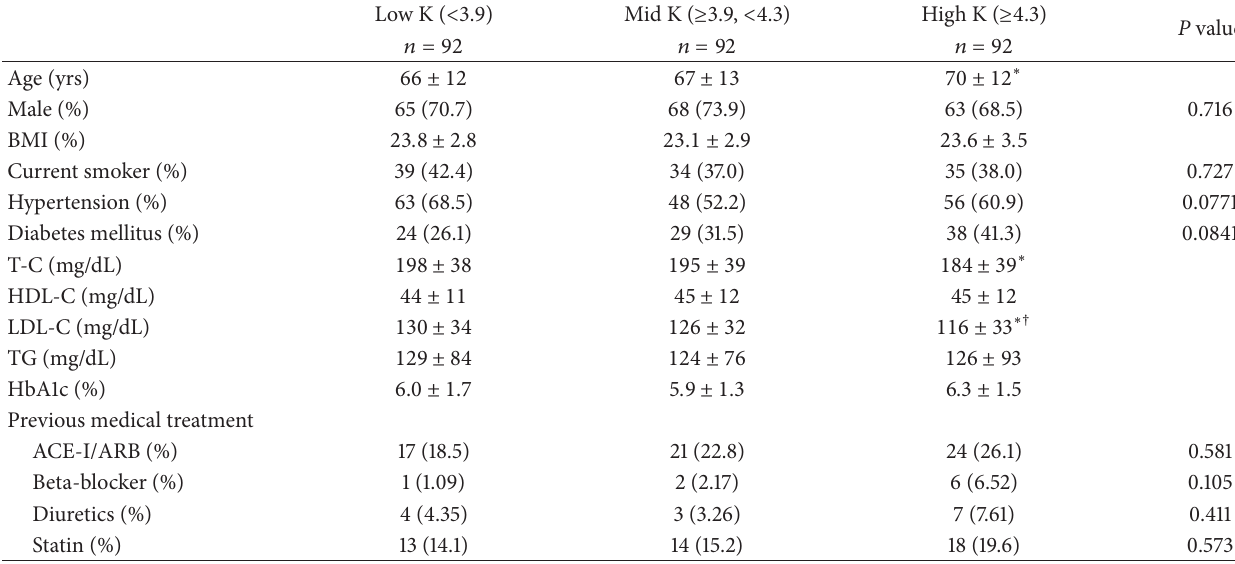
Table 1: Clinical characteristics of the patients at